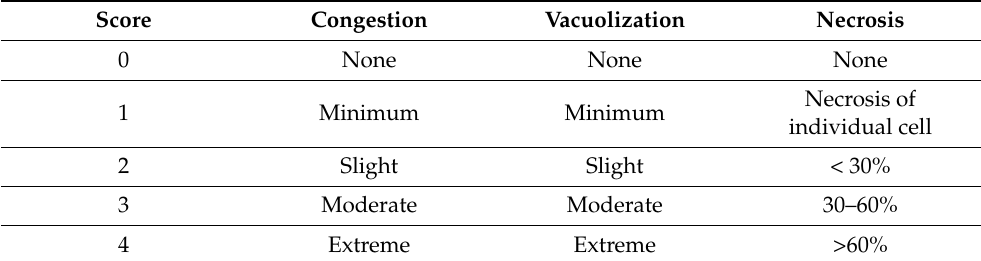
Table 6. Characteristics of liver ischemia–reperfusion injuries. Score Congestion Vacuolization Necrosis 0 None None None Necrosis Minimum Minimum